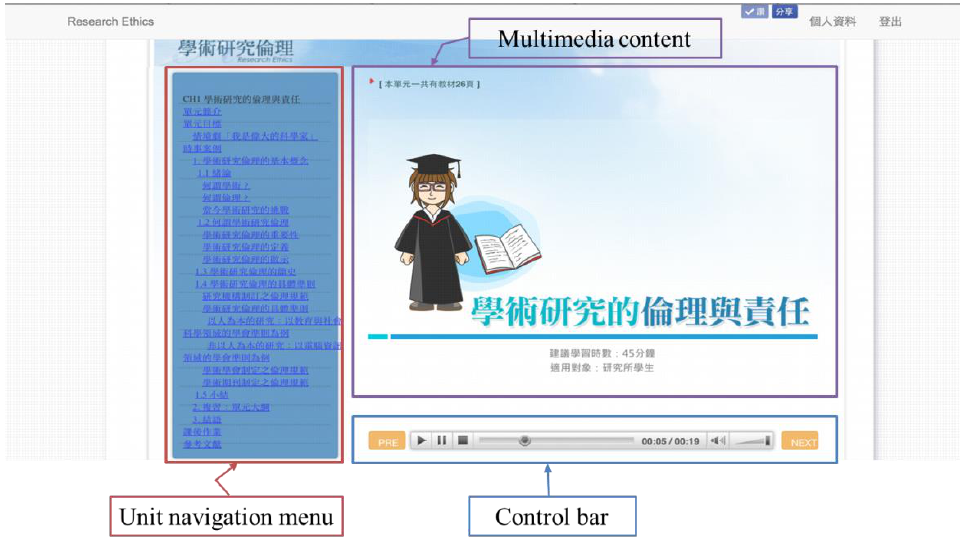
Figure 3. Screenshot of the online